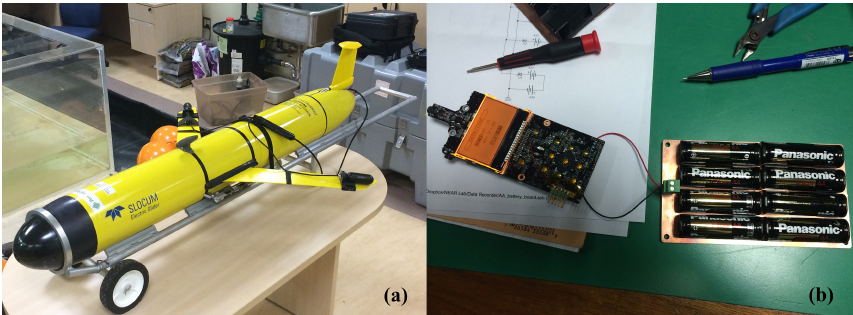
Figure 1. (a) The PSU glider Clyde with hydrophones attached to the tips of its wings. (b) The acoustic recording system (modified Tascam digital recorder) and battery pack.